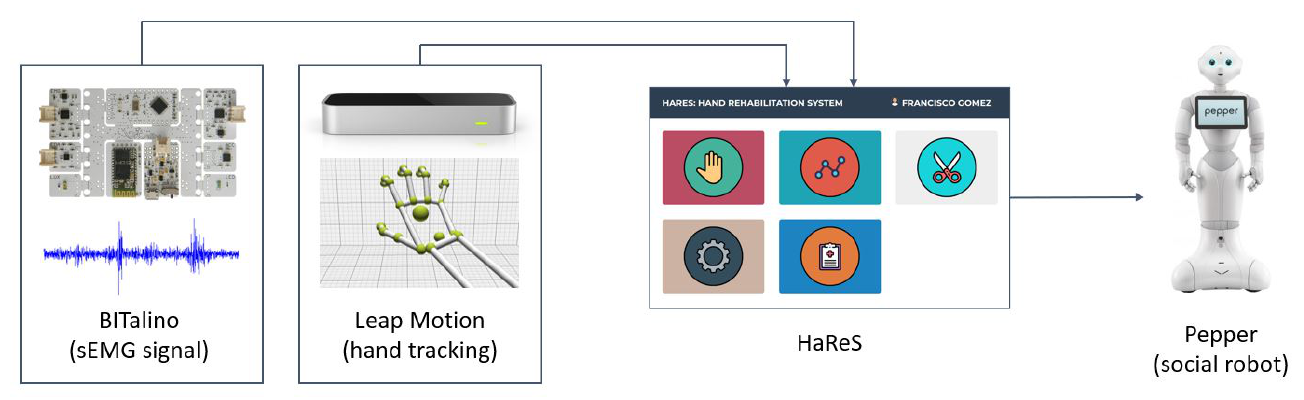
Figure 1. Architecture of HaReS, a hand rehabilitation system, featuring surface electromyography (sEMG) and hand tracking low-cost